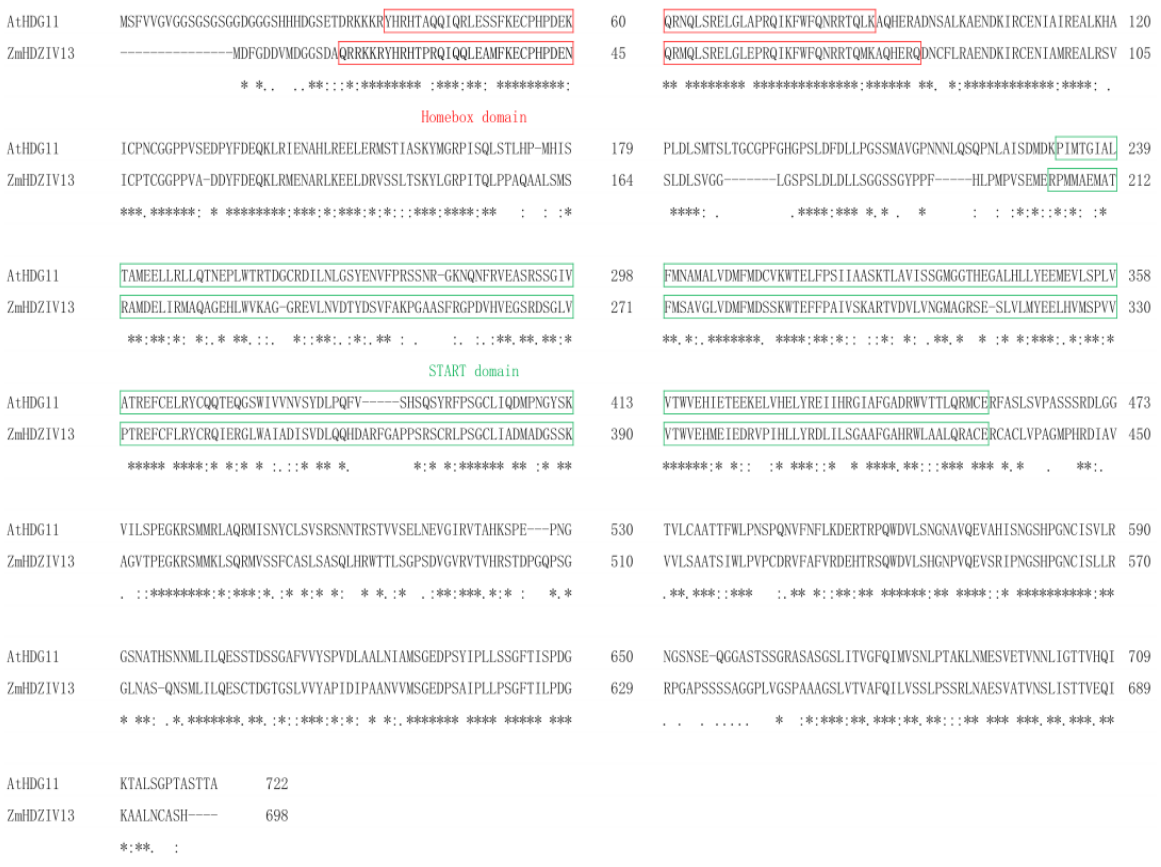
Figure 1. Homology analysis of ZmHDZIV13 and At HDG11 amino acid sequences.